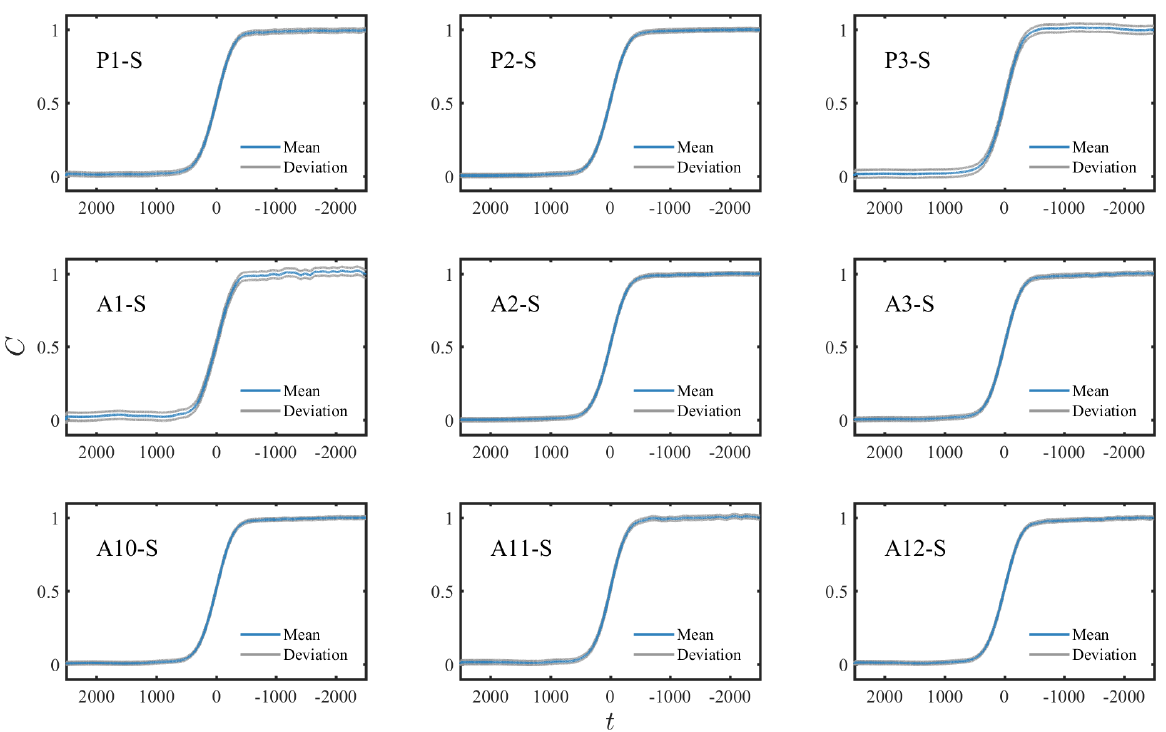
Figure A2. Experimental error estimate for five repeated runs. The blue curve is the mean of the experiments that measured at the south (S) branch at each location and the gray curve is the average deviation.